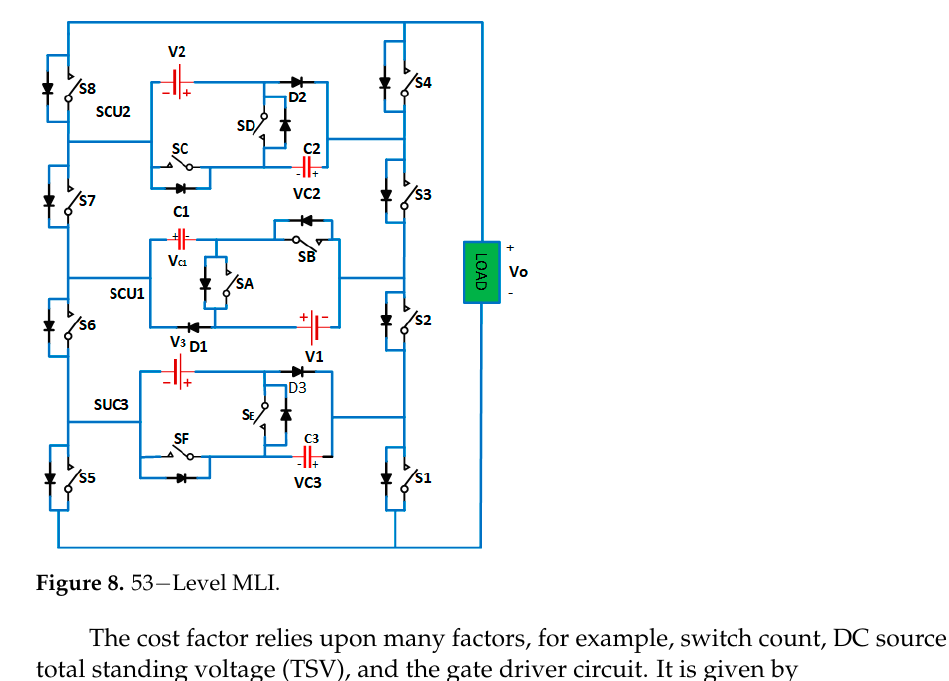
10 of 26 Figure 7. 25 − Level MLI. 2.1.4. Using Three DC sources In [60], the part count per level and the TSV bring about a higher value. To further avoid the present circumstance in the MLIs, a new proposed [29] topology produces a 53- level result where a switched capacitor (SC) is placed at the front side alongside the H- bridge as shown in Figure 8. It boosts the voltage and makes the operation of capacitor charging and discharging simple. Utilizing many quantities of capacitors prompts an in- crement in the levels of the MLI. During ideal circumstances, capacitor 𝐶, which is at the front side of MLI, is charged to voltage 𝑉1 when it is associated with the corresponding